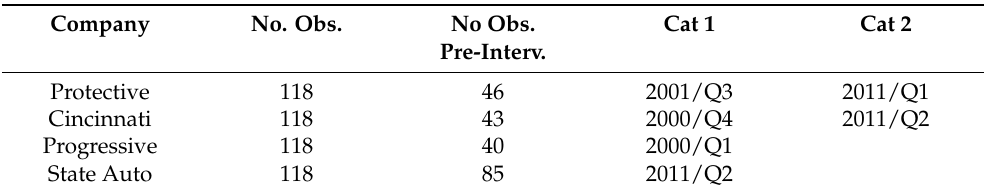
Figure 3. Quarterly loss ratio data for four insurance companies: 1990/Q1–2019/Q2. (Source: Bloomberg). Table 1. Data description. Quarterly Loss Ratios on US Property and Casualty